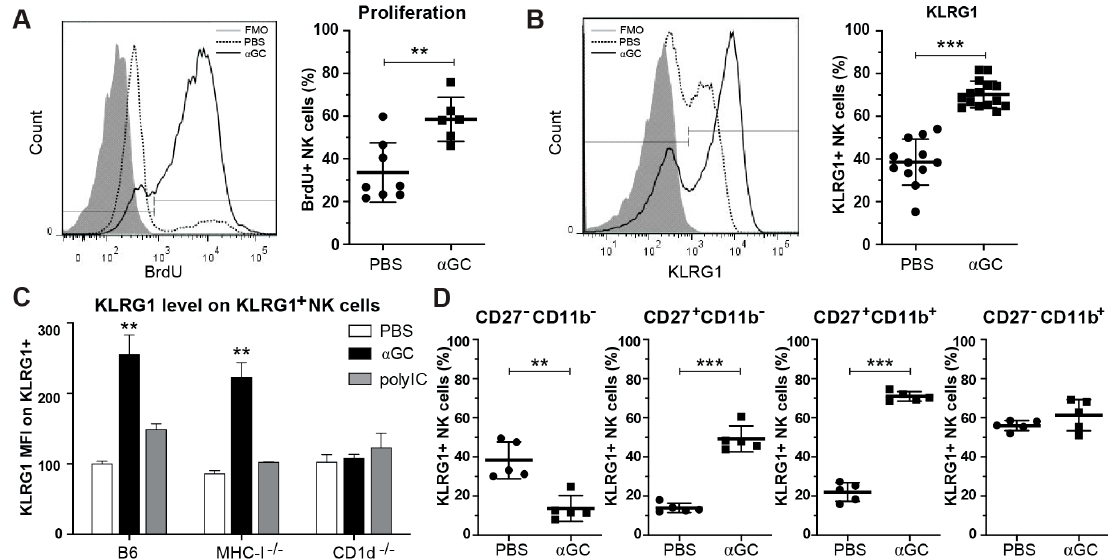
Figure 1. iNKT cell-dependent activation of NK cells by α GC in vivo. C57Bl/6 or CD1d − / − mice were injected i.v. with PBS or soluble α GC. ( A ) B6 mice were fed BrdU in drinking water for 7 days and proliferation of NK cells was quantified by staining for BrdU (defined as BrdU + of TCR- β − or CD3 − , NK1.1 + live lymphocytes). ( B ) Frequency of KLRG1 + NK cells and ( C ) mean fluorescence intensity (MFI) of KLRG1 + cells at day 3 after treatment of C57Bl/6, MHC-I − / − or CD1d − / − mice with PBS, α GC or polyI:C. MFI was normalized to expression level of PBS-treated B6 mice within each experiment. ( D ) Frequency of KLRG1 + NK cell subsets based on expression of maturation markers CD27 and CD11b. Data are pooled from 2–4 independent experiments and show results for ( A ) 6–8 mice per group ( B ) 12–16 mice per group ( C ) 4–9 mice per group for B6, 4–5 mice per group for MHC-I − / − and CD1d − / − , ( D ) 5 mice per group. Statistical differences were calculated using unpaired two-tailed t -tests for ( A , B , D ) and Kruskal–Wallis test with Dunn’s correction for multiple testing within each group of mice compared to PBS-treated control ( C ) Error bars indicate mean ± SD and statistical significance is indicated as ** p < 0.01. *** p < 0.001.